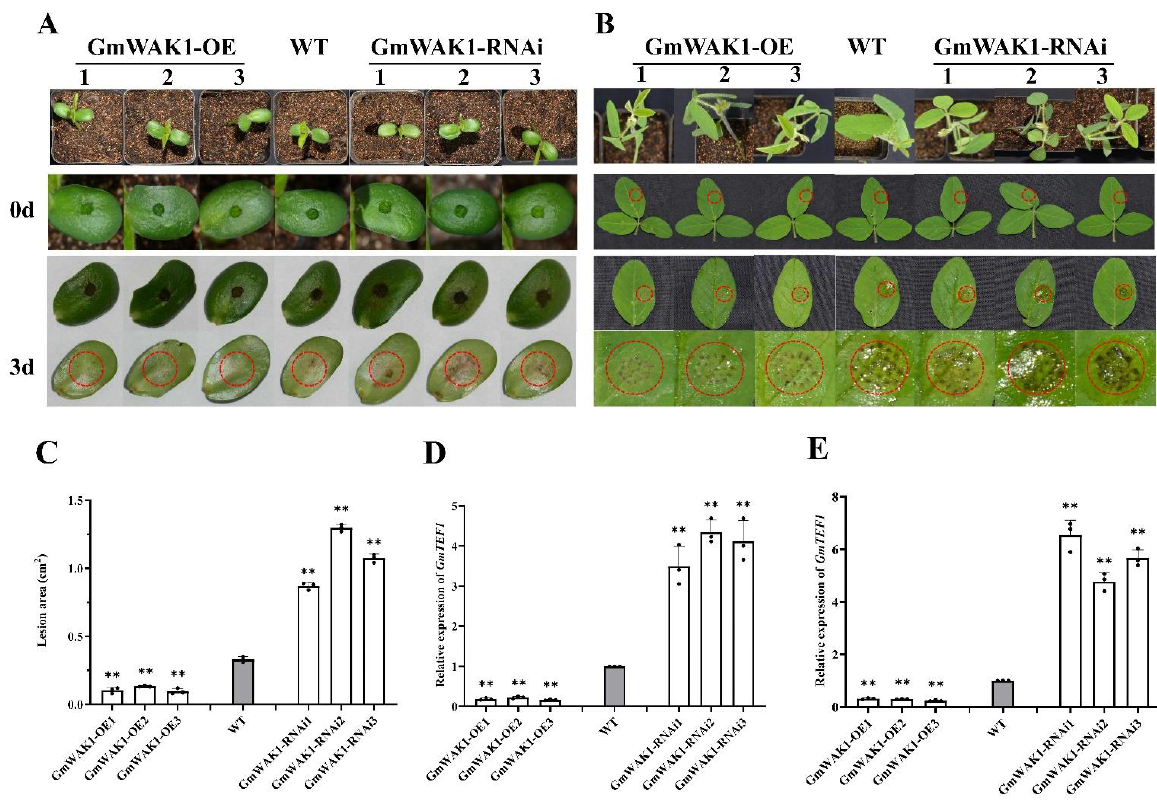
Figure 3. Phenotype identification of GmWAK1 under P. sojae influence in transgenic soybean plants. ( A , B ) Disease symptoms on living cotyledons and leaves of transgenic and WT plants treated with P. sojae inoculum at 0 and 3 days, respectively. ( C ) Lesion area of transgenic lines and WT plants detected after 3 days of incubation with P. sojae . ( D , E ) Results of qRT-PCR analysis of relative biomass of P. sojae in GmWAK1 transgenic lines and WT soybean based on P. sojae TEF1 transcript levels. Three biological replicates, each with three technical replicates; ** p < 0.01, Student’s t test; error bars indicate standard deviation.